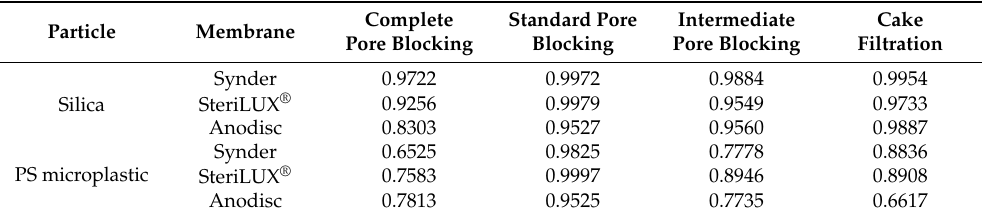
Table 2. R 2 values corresponding to the fouling mechanisms estimated by the blocking filtration model for silica particles and PS microplastics during the three different membrane filtrations. Complete Standard Pore Intermediate Particle Membrane Pore Blocking Blocking Pore